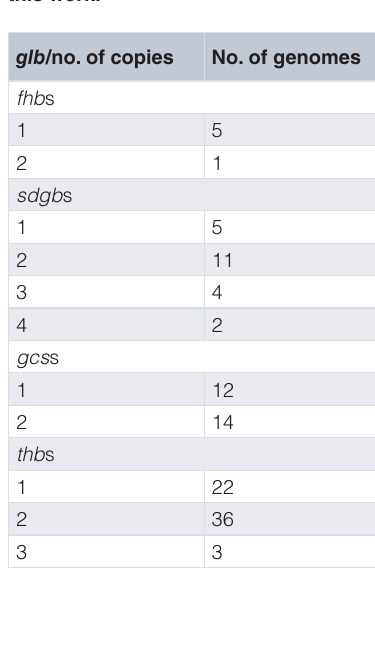
Table 1. Number of glb copies detected in the rhizobial genomes analyzed in this